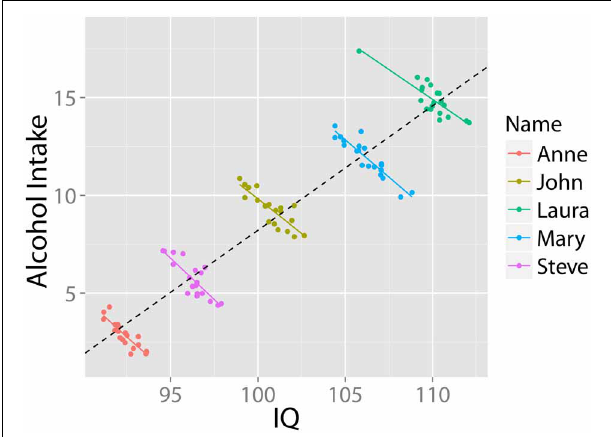
FIGURE 2 | Alcohol use and intelligence. Simulated data illustrating that despite a positive correlation at the group level, within each individual there exists a negative relationship between alcohol intake and intelligence. Data in arbitrary